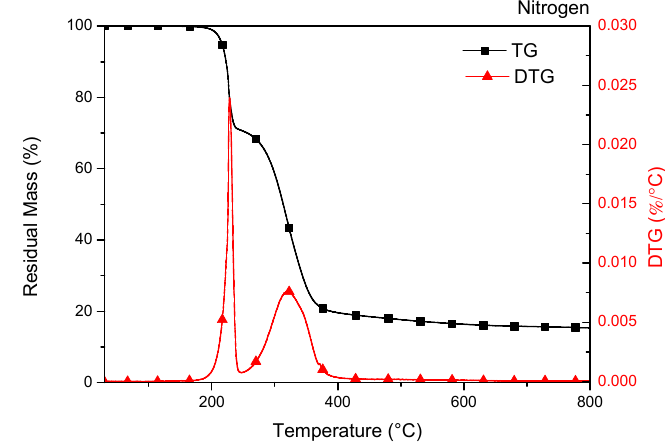
Figure 2. TG (residual mass) and DTG (derivative weight loss) curves of caffeic acid powder under nitrogen atmosphere.